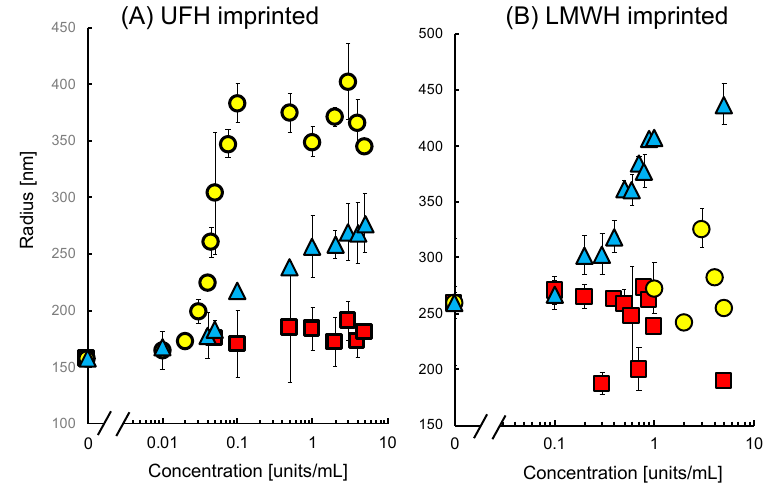
Figure 2. The relationship between the radii of ( A ) UFH-MIP-NP and ( B ) LMWH-MIP-NP and the concentrations of UFH (yellow circles), LMWH (blue triangles), and chondroitin sulfate C (CSC) (red squares).